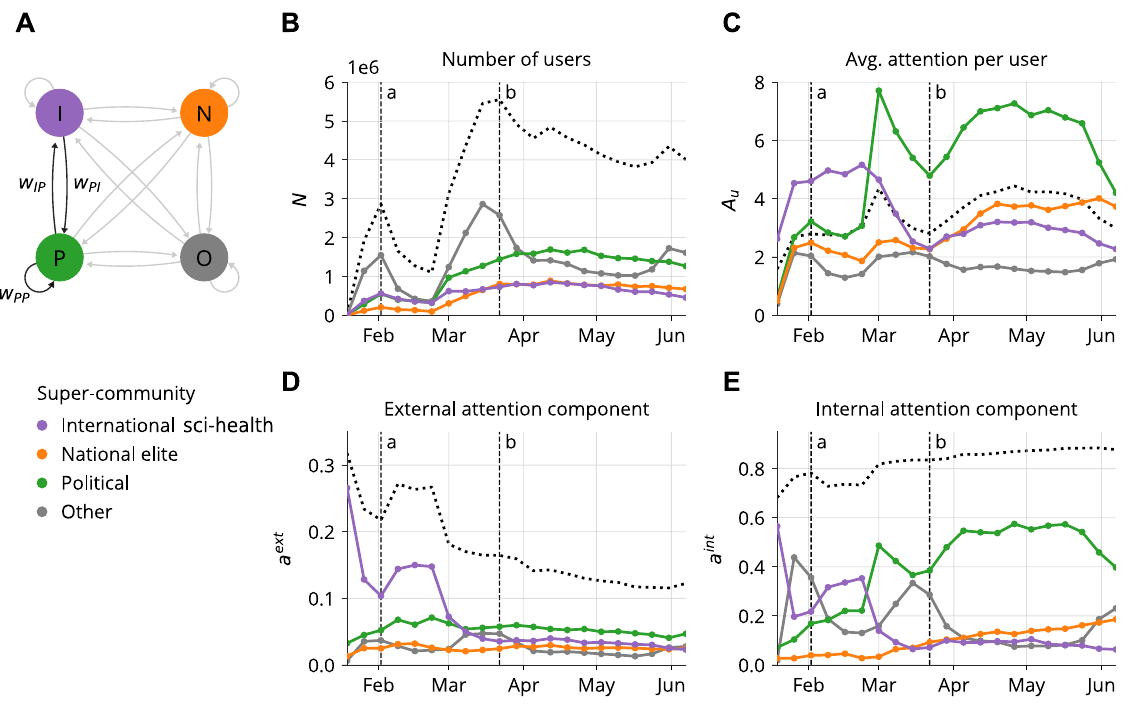
Figure 4. Evolution of weekly aggregated networks by super-community, with dotted lines corresponding to the statistics across all users. ( A ) Diagram representing the networks collapsed to the super-community level. Edge direction represents the flow of information via retweets, i.e. from retweeted to retweeting super- community. ( B ) Size of the super-communities in terms of number of users. ( C ) Average attention per user. ( D ) External component of the attention toward super-communities. ( E ) Internal component of the attention toward super-communities. Indicated as a and b are the first and second peak in terms of network size, as shown in Fig.